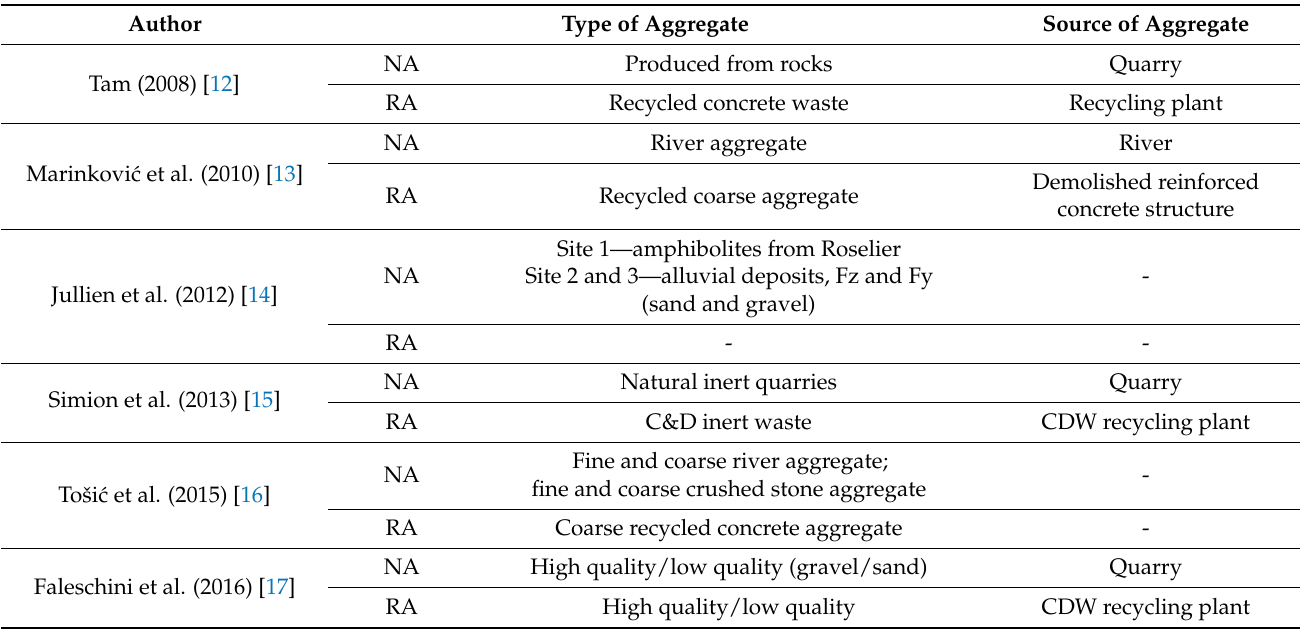
Table 1. Type and source of aggregate from each study.